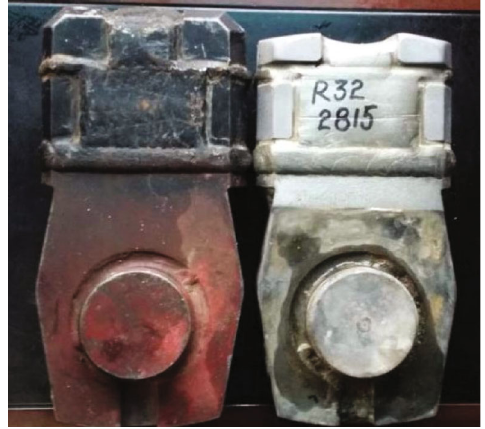
Figure 10: The new type of the tearing cutter.